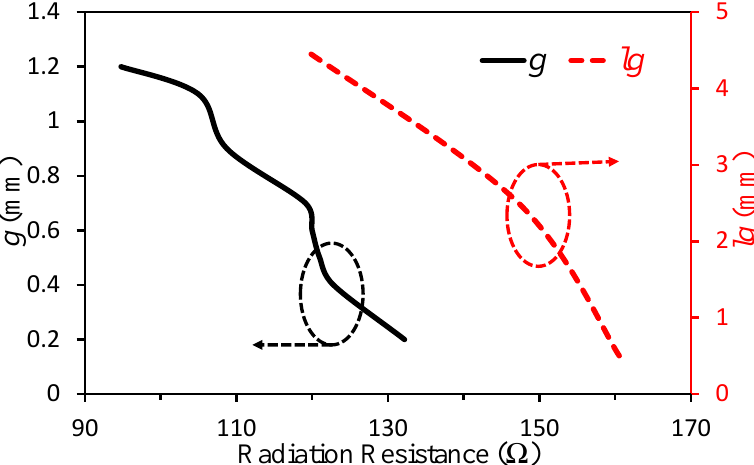
Figure 2. Radiation resistance of the antenna with varying g (when lg = 4.5 mm) and lg (when g = 0.7